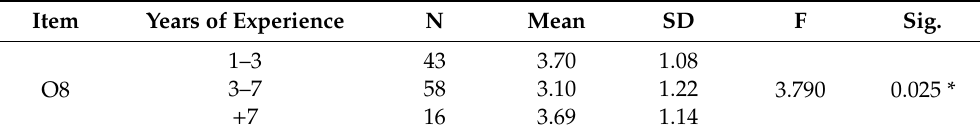
Table 4. Items with significant di ff erences depending on the years of experience variable. Item Years of